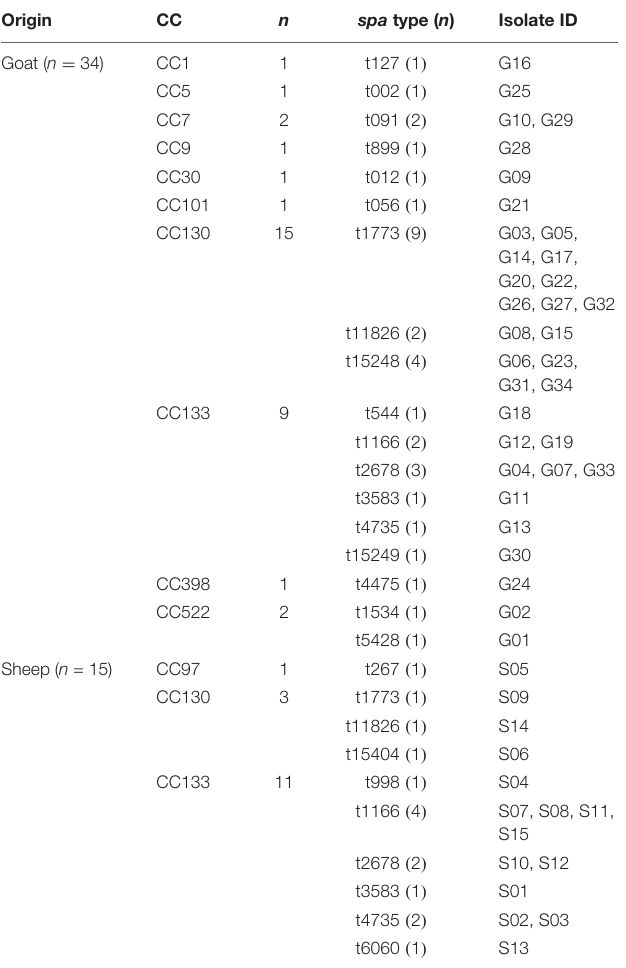
TABLE 2 | Clonal complexes (CC) and spa types of the S. aureus isolates from goat and sheep milk.